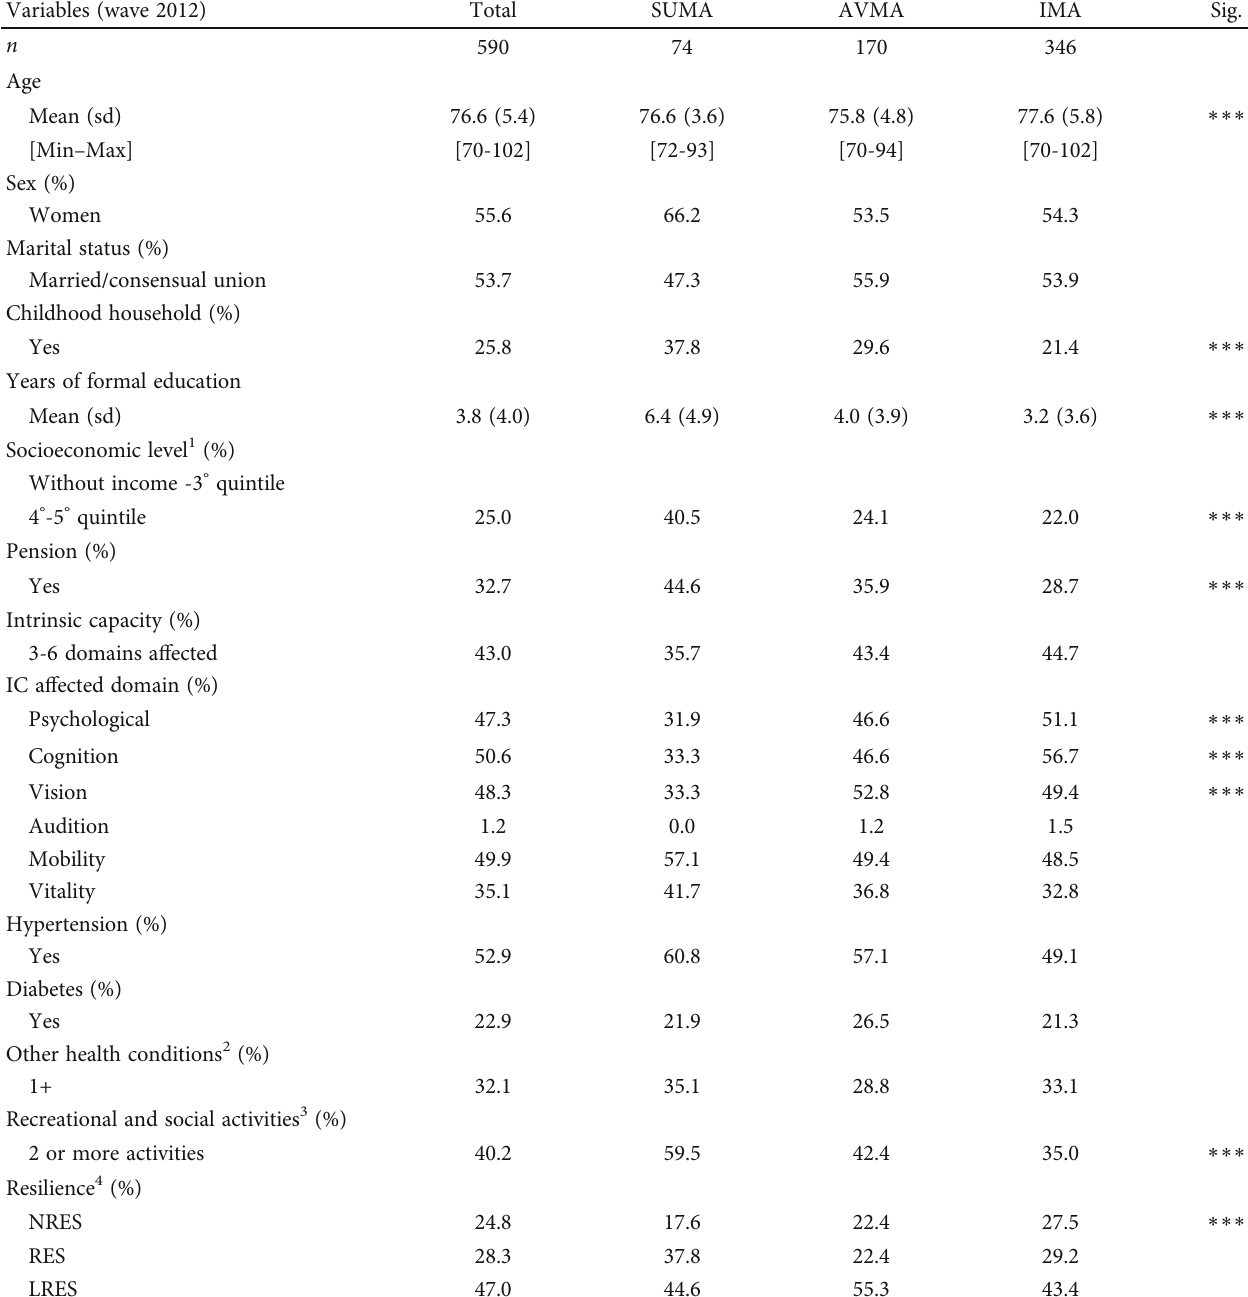
Table 1: Characteristics of the study sample from baseline (2012) ( n = 590